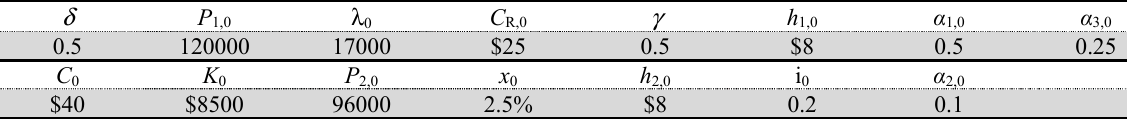
The assumed values of stage one’s relevant variables